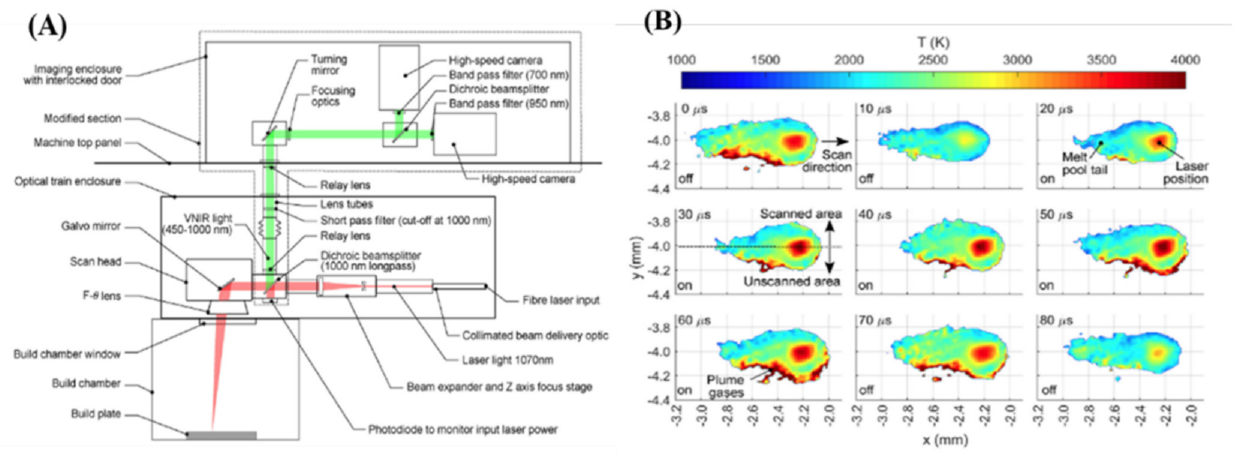
Figure 7. Schematic of the optical path ( A ) and representative temperature maps ( B ) of a high-speed two-wavelength pyrometric imaging apparatus [67].